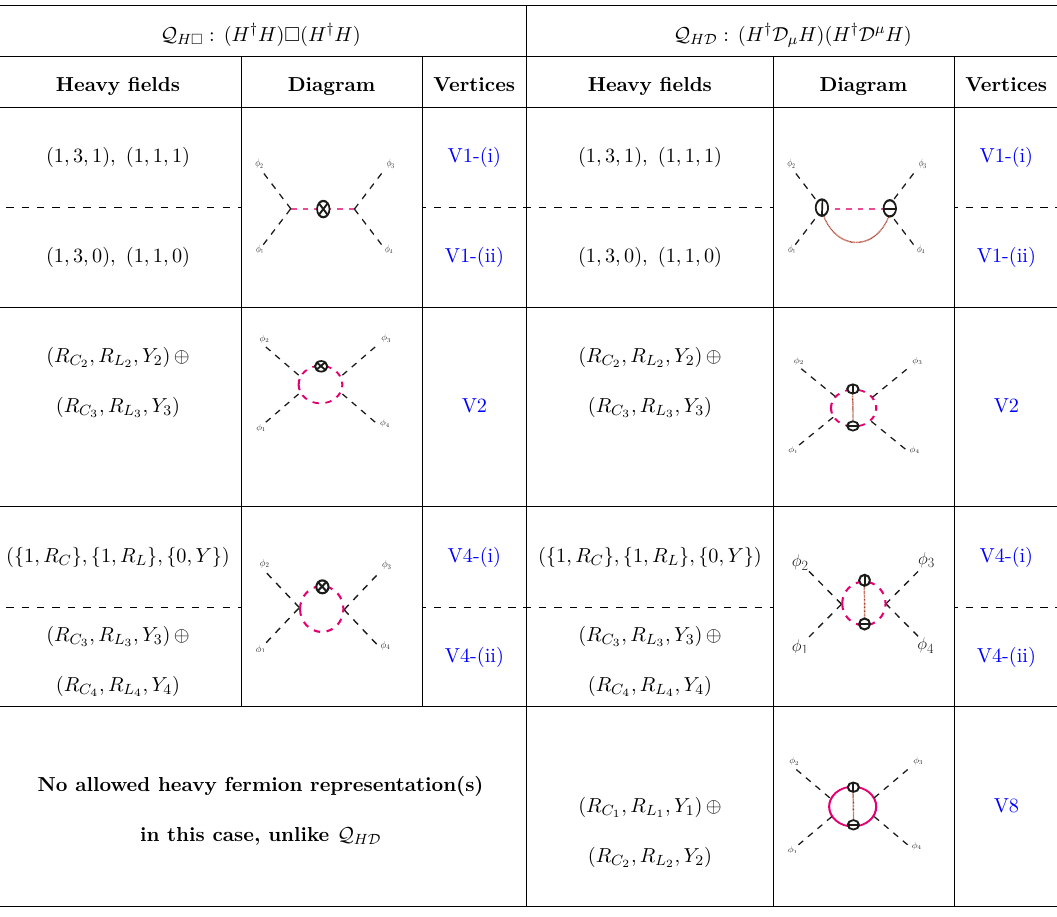
Table 6 . Heavy field representations that are obtained by unfolding the φ 4 D 2 operators into non- trivial tree- and (or) one-loop-level diagrams and the corresponding vertices. The entries for the operators Q and Q have been presented side by side to allow for an easy comparison between H D H (cid:3) the